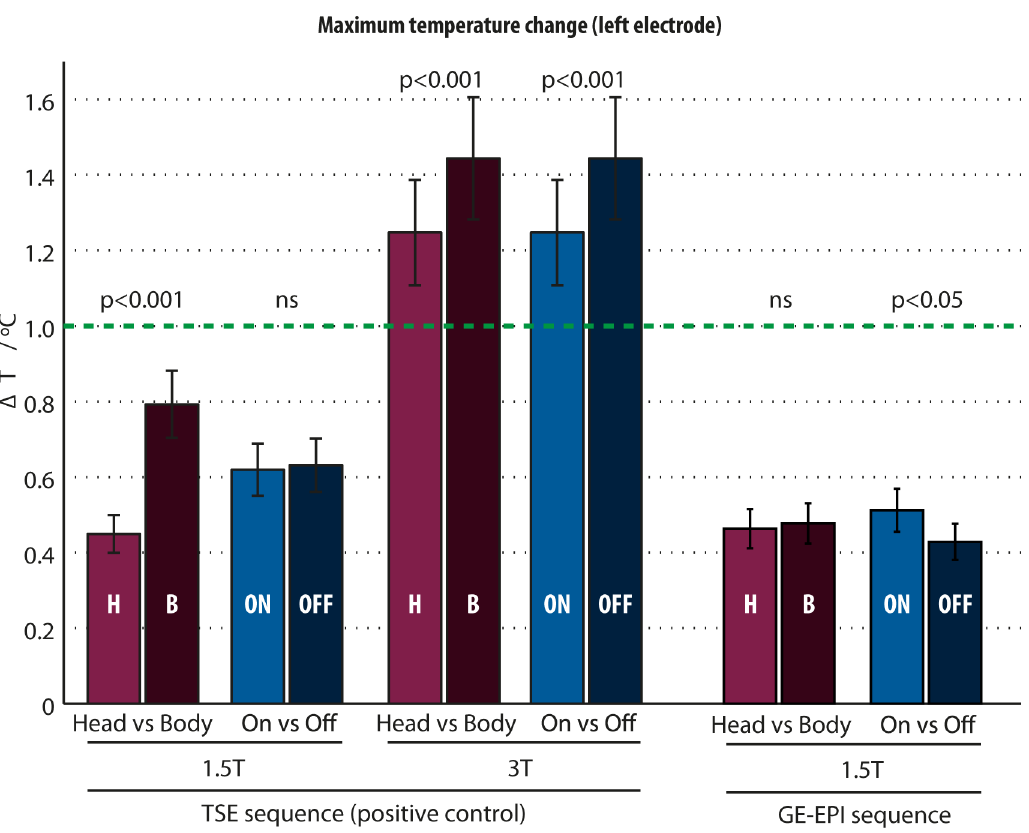
Fig 6. Maximum electrode-tip temperature change induced by the TSE sequence at 1.5T and 3T systems, and GE-EPI sequence at